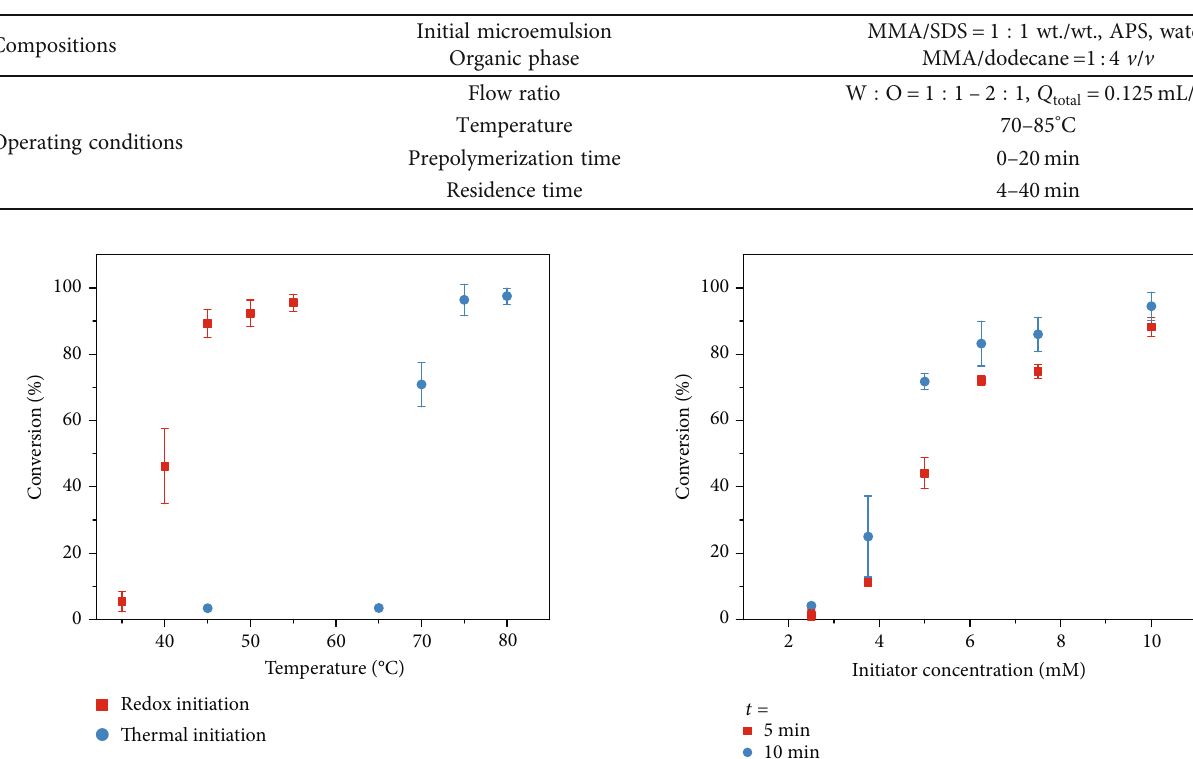
Figure 1: Schematic overview of the di ff erential microemulsion polymerization carried out in a biphasic slug fl ow. Table 1: Speci fi ed parameters of continuous di ff erential microemulsion polymerization.